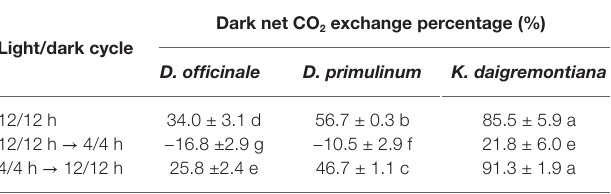
TABLE 1 | Effect of light/dark cycle on dark net CO 2 exchange percentage of D. officinale , D. primulinum , and K. daigremontiana .